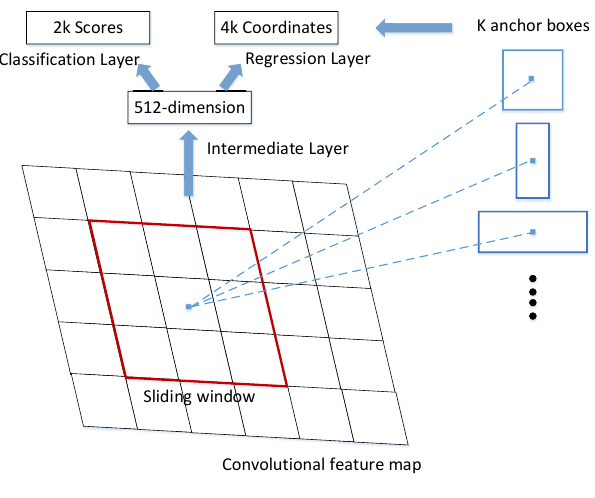
Figure 3. Structure of